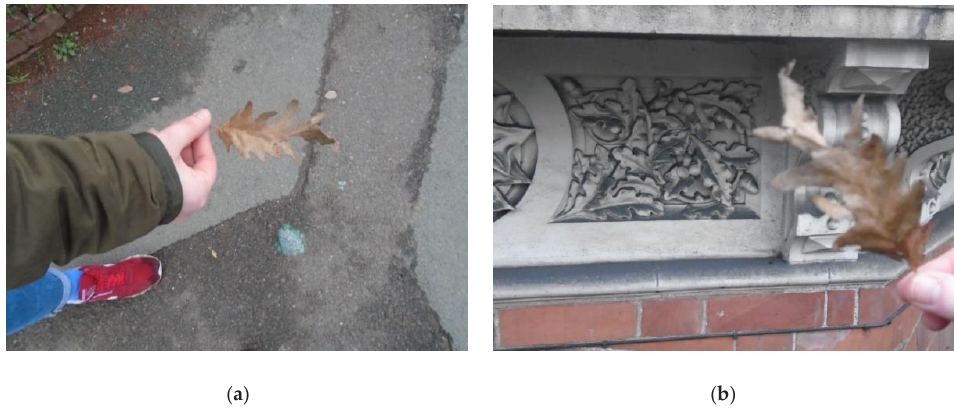
Figure 27. ( a ) Oak leaf; ( b ) Carved representations of oak leaves.